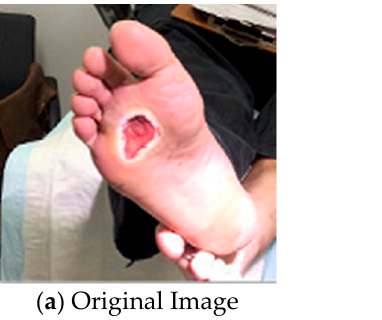
Figure 5. The probabilities of wound types: Diabetic: 95.36%, pressure injury: 4.07%, lymphovascular: 0.01%, surgical: 0.55% (Diabetic).